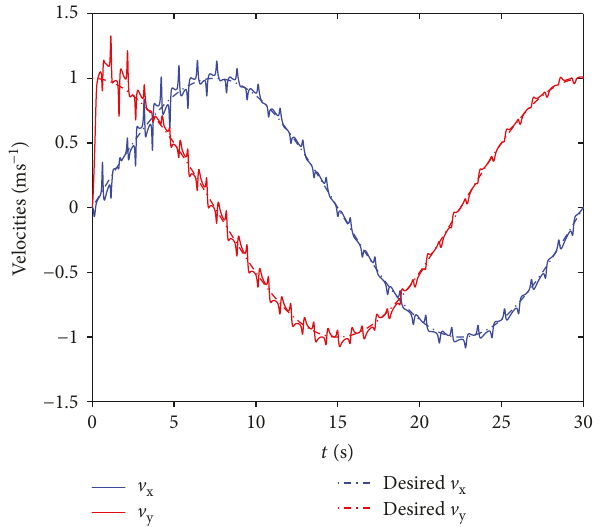
Figure 6: Velocity tracking (circle-path